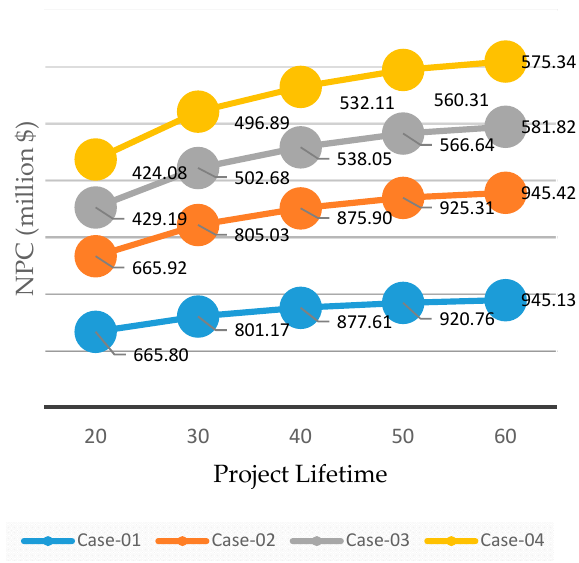
Figure 16. Sensitivity Assessment of Project Lifetime on NPC.